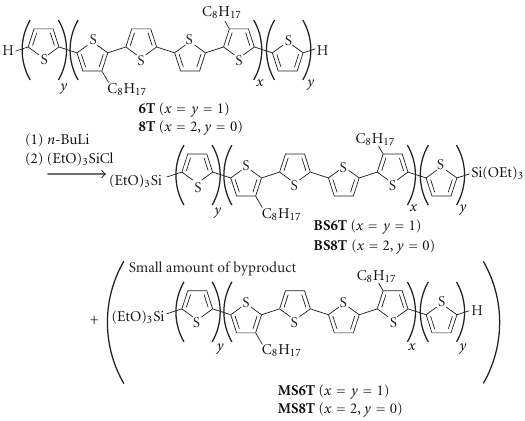
Scheme 2: Synthesis of BS n T and MS n T ( n = 6 and 8).